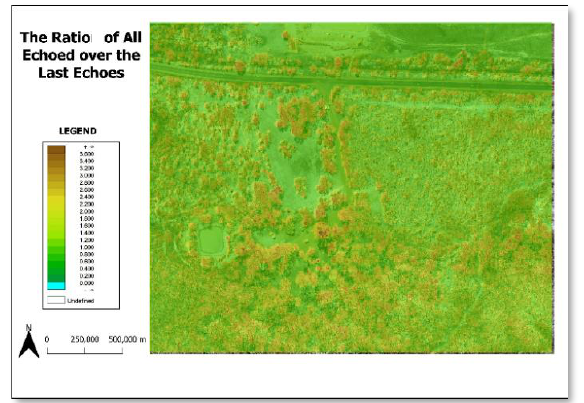
Figure 4. output from the ratio of the overall echoes and the last echo overlayed on the aerial imagery